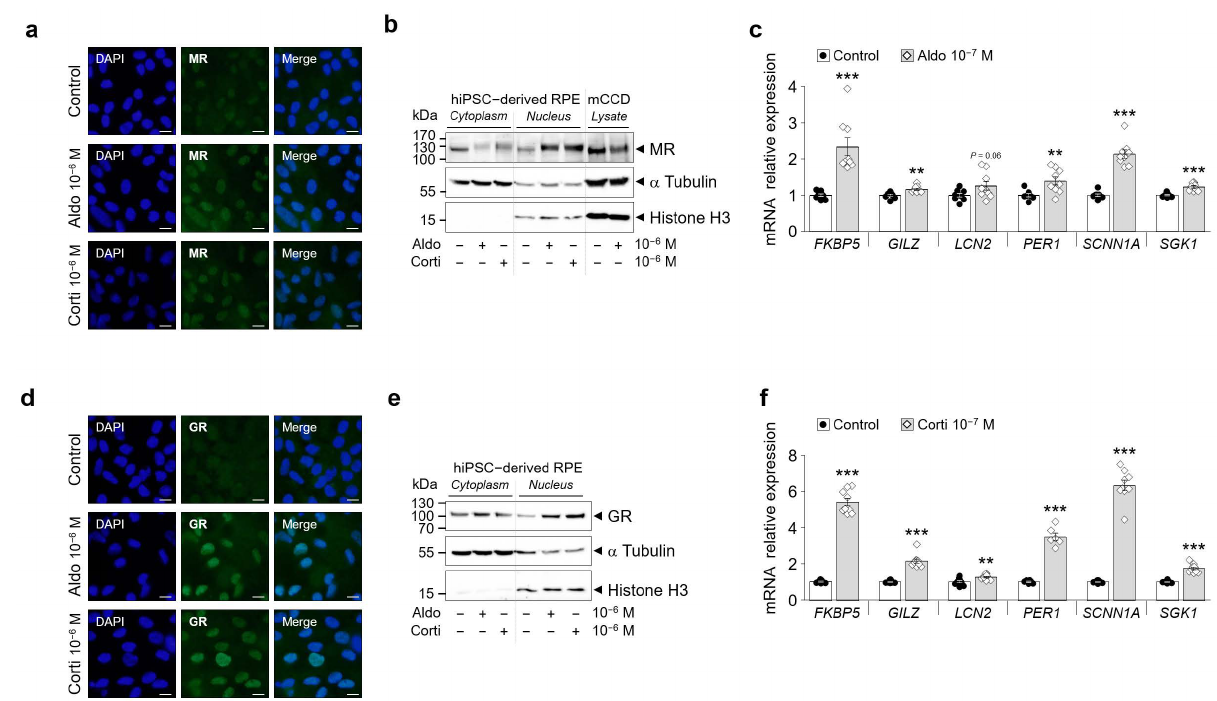
Figure 3. GR and MR are functional in hiPSC-derived RPE cells (iRPR). ( a ) and ( d ) Representative analysis by immunofluo- rescence of endogenous MR ( a ) and GR ( b ) protein expression following aldosterone (aldo) or cortisol (corti) 1h treatment (10 − 6 M) in iRPE cells. MR and GR staining is in green, and DAPI staining is in blue. Scale bar: 5 µ m. ( b ) and ( e ) Analysis by Western blot of endogenous MR ( b ) and GR ( e ) protein expression following aldosterone or cortisol 1h treatment (10 − 6 M) in iRPE cells cytoplasmic or nuclear fractions. As a positive control for MR protein expression, mouse cortical collecting duct cells (mCCD) with known functional MR expression were treated for 1 h with 50 nM aldosterone. α -Tubulin and Histone H3 were used as loading controls for the cytoplasmic and nuclear fractions, respectively. Arrows indicate the expected size of the 107 kDa MR, 94 kDa GR, 50 kDa α -Tubulin and 15 kDa Histone H3 proteins. ( c ) and ( f ) Analysis by RT-qPCR in iRPE cells following aldosterone ( c ) or cortisol ( f ) 24 h treatment (10 − 7 M) of the expression profile of genes ( FKBP5 , GILZ , LCN2 , PER1 , SCNN1A , SGK1 ) known to be up-regulated by corticosteroids. mRNA transcript expression was relative to the expression of the housekeeping gene GAPDH . n = 6–9 per experimental condition. Values are means ± SEM. ** p < 0.01, *** p <